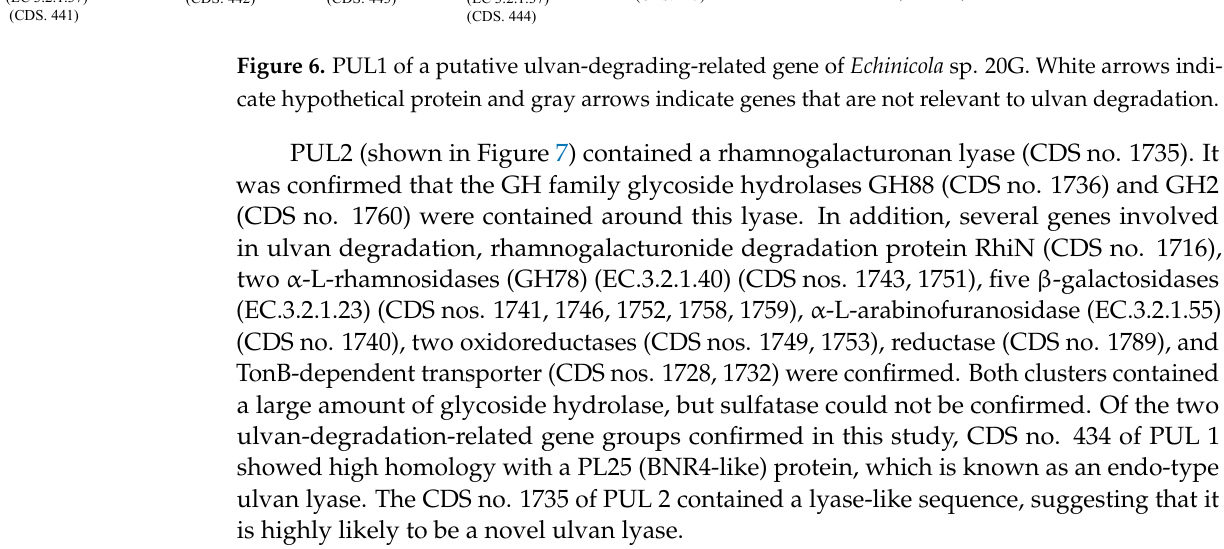
Figure 6. PUL1 of a putative ulvan-degrading-related gene of Echinicola sp. 20G. White arrows in- dicate hypothetical protein and gray arrows indicate genes that are not relevant to ulvan degrada- tion.